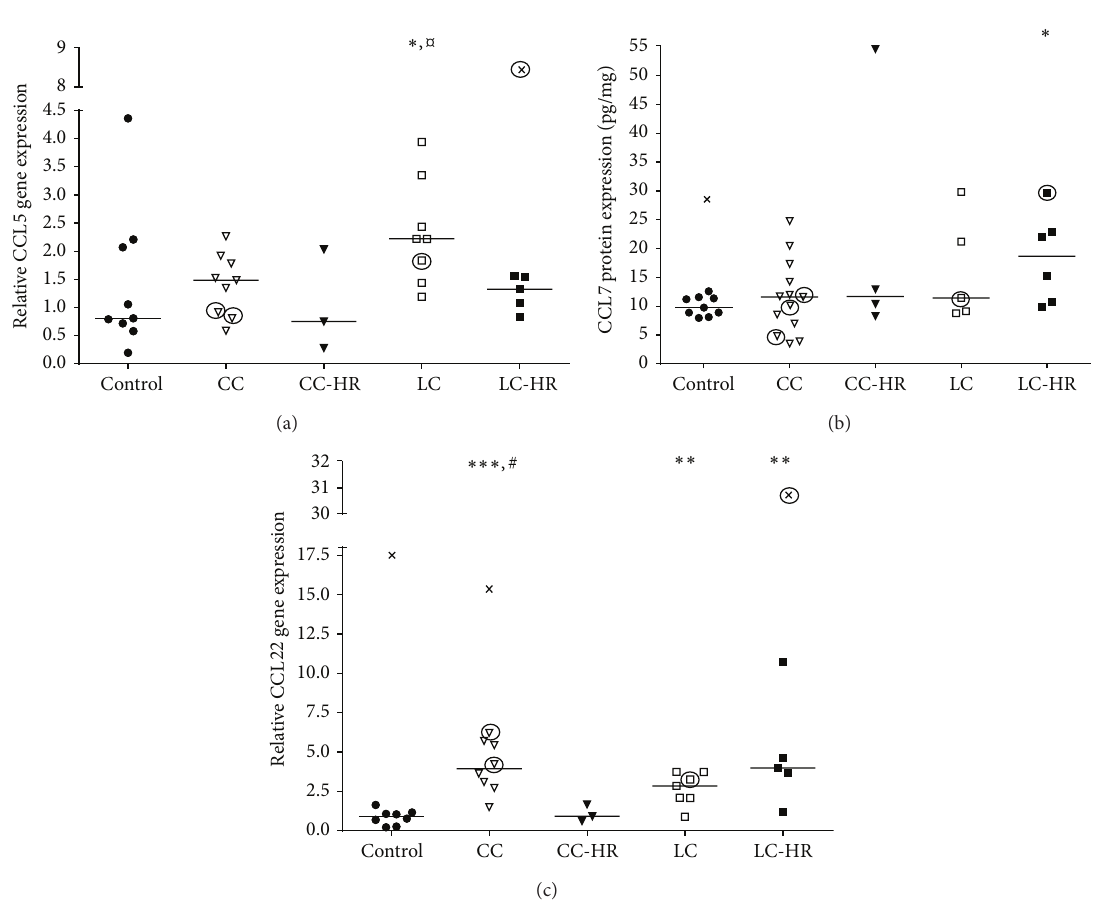
Figure 6: Relative gene and protein expressions of CC chemokines involved in recruitment of eosinophils, neutrophils, macrophages, Treg, Th1, and/or Th2 cells. Each symbol represents one patient and the medians are depicted as a line. Statistical outliers are marked as crosses (X) and budesonide treated patients are encircled. ∗ 𝑃 < 0.05 , ∗∗ 𝑃 < 0.01 , and ∗∗∗ 𝑃 ≤ 0.001 versus controls, # 𝑃 < 0.05 versus CC-HR, and ¤ 𝑃 < 0.05 versus